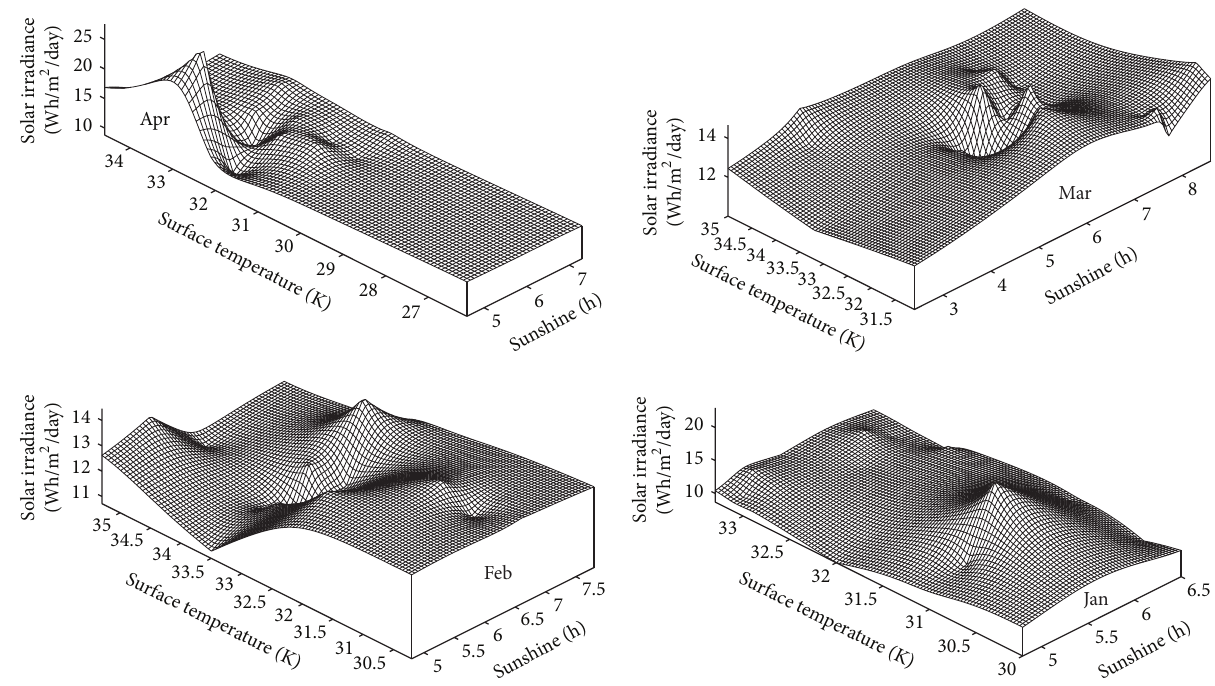
Figure 5: Weather parameter trend for January–April.